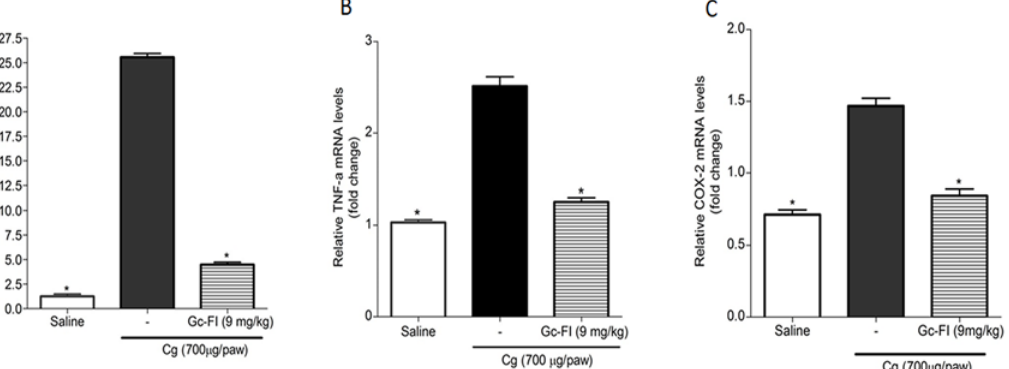
Fig 6. Effect of Gc-FI (9 mg/kg, s.c.) on the expression levels of IL-1 β (A), TNF- α (B) and COX-2 (C). * p < 0.05 compared with the Cg group (ANOVA, Bonferroni test).